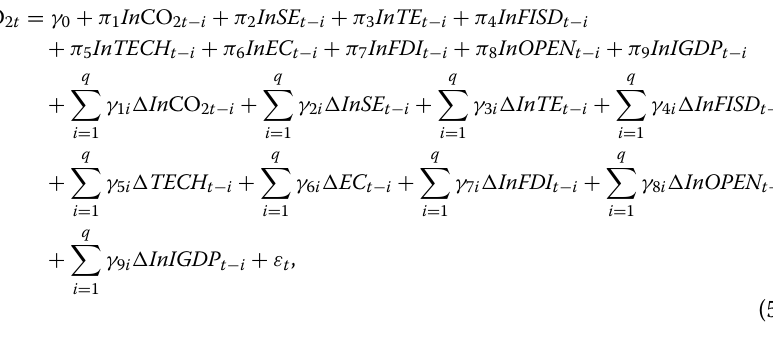
N/A Not available; WDI World Development Indicator; IMF International Monetary Fund